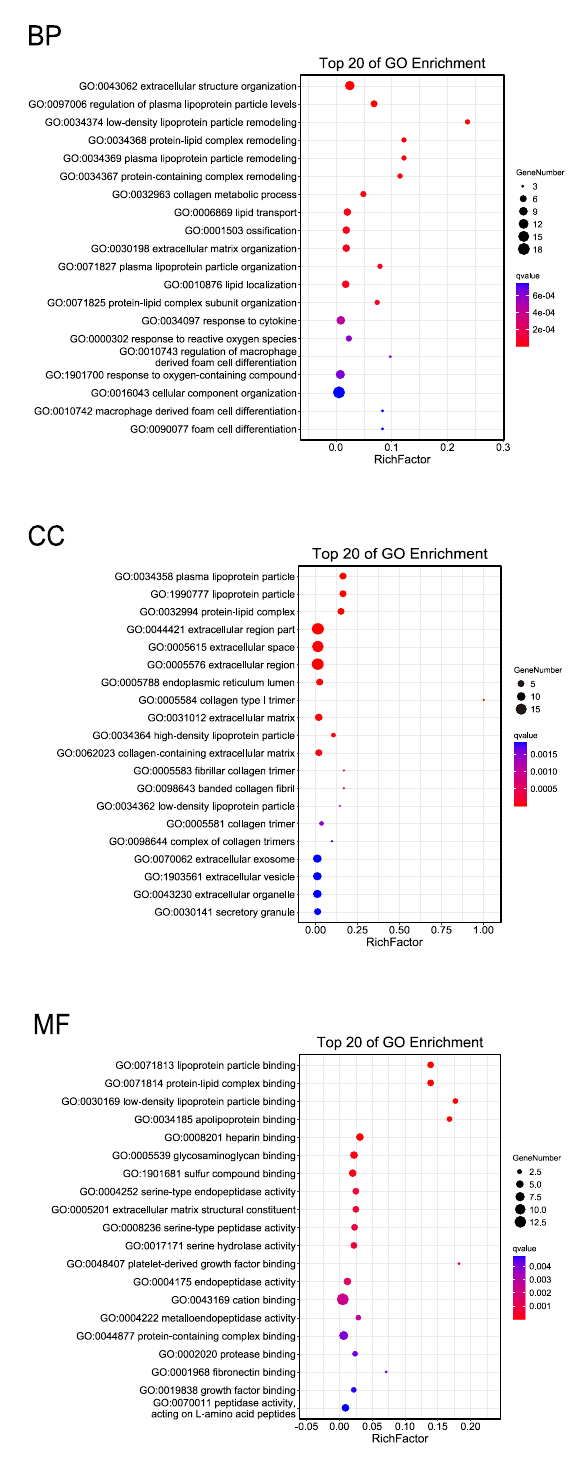
Figure 4. Biological functions based on Gene Ontology (GO) analysis of obesity-related hub genes. Advanced bubble chart shows significance in GO enrichment items of hub genes in three functional groups: biological process (BP), cell composition (CC), and molecular function (MF). The x-axis label represents the gene ratio (Rich Factor) and the y-axis label represents GO